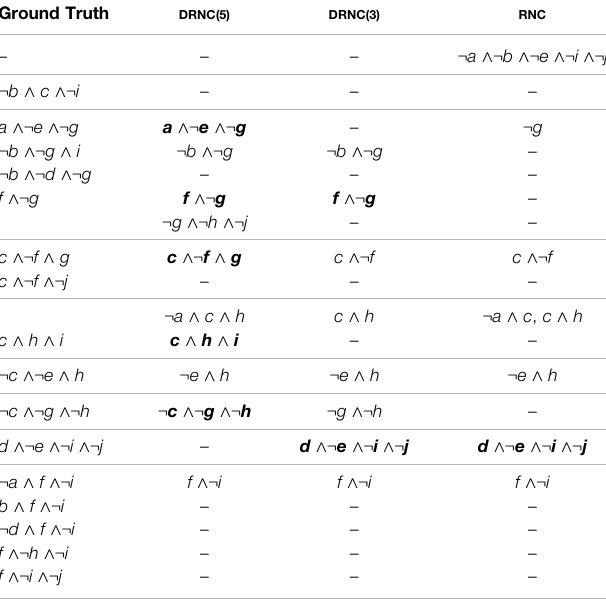
TABLE4| DNFmodelsofdeepandshallowrulenetworksforarti fi cialdatasetwith seed 44. Each row shows a rule (body), which are disjuncted for the fi nal model. Rules that are also contained in the ground truth are marked in bold.